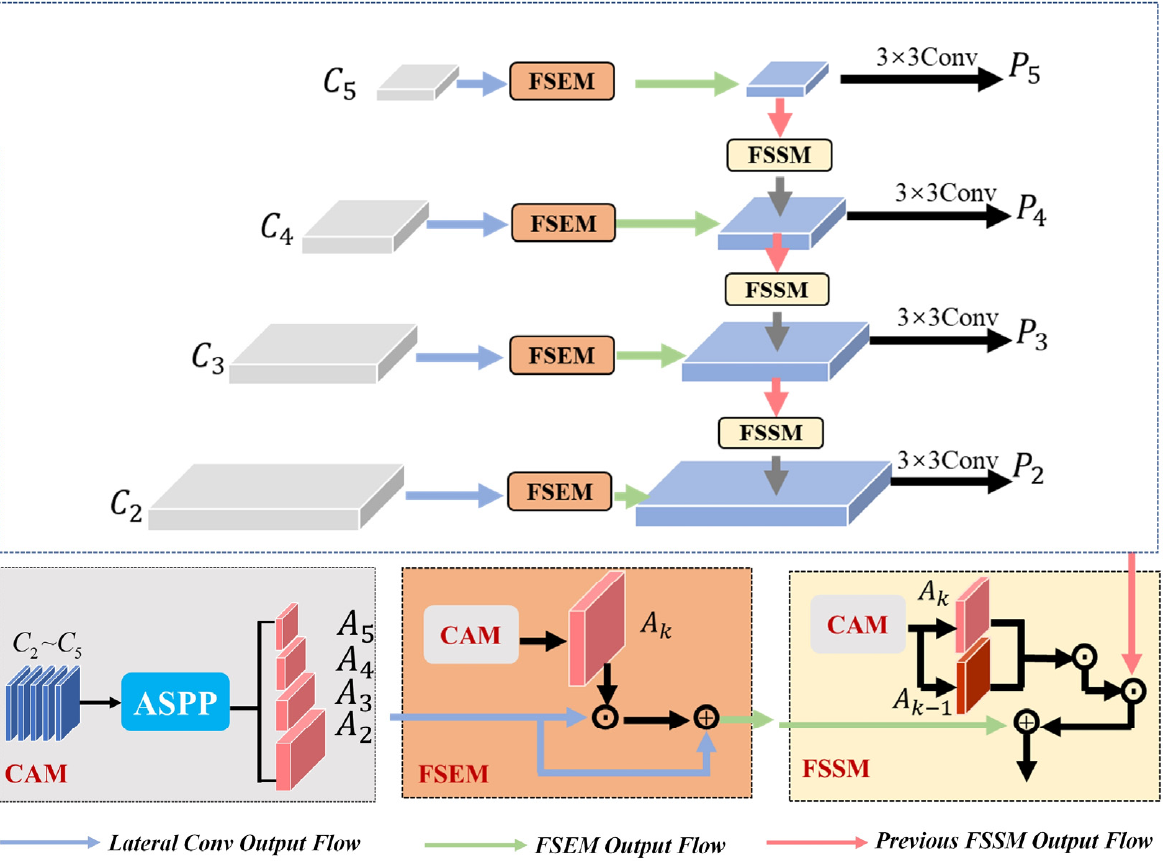
Figure 3. The FSSPN framework.